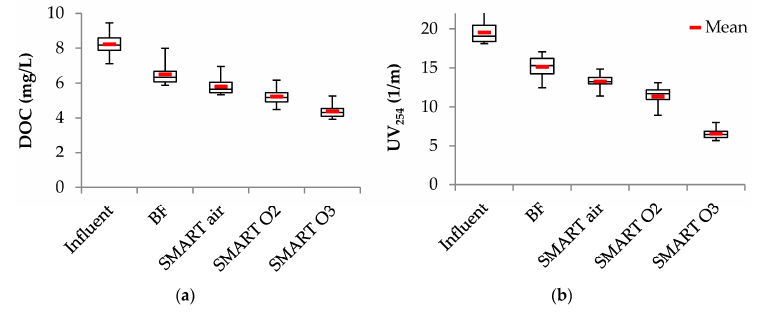
Figure 3. DOC concentrations ( a ) and UV 254 absorbance values ( b ) of the influent and the effluents of all four systems: Bank filtration (BF), sequential managed aquifer recharge technology (SMART) air, SMART O 2 , SMART O 3 ( n ≥ 16). Whiskers indicate maximum and minimum values.